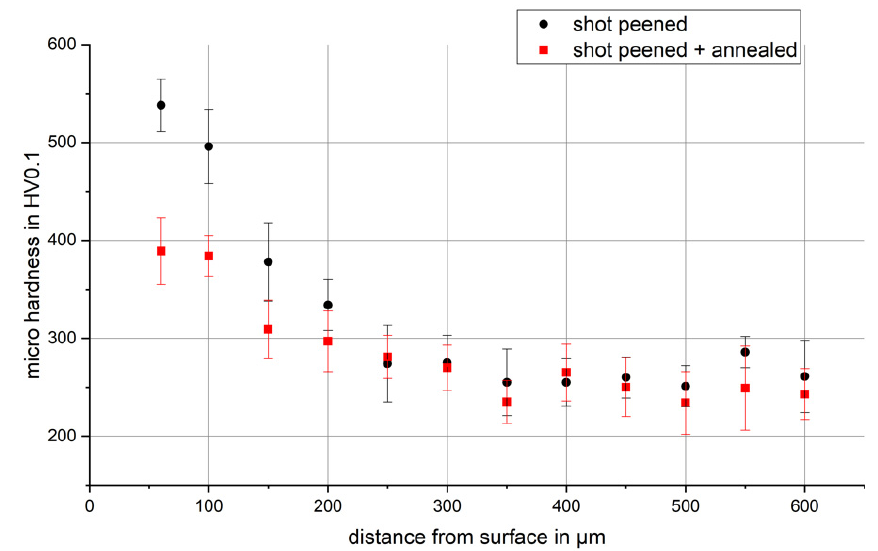
Figure 3. Hardness over distance from the surface.